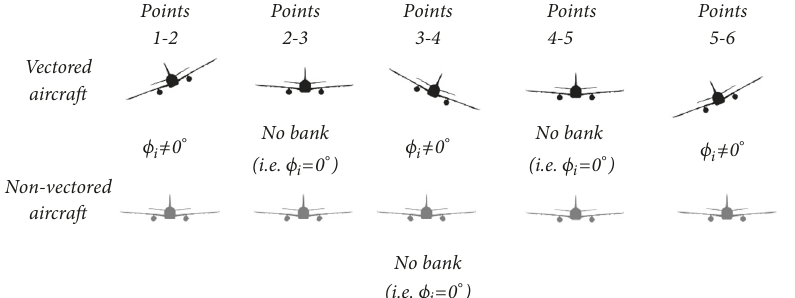
Figure 5: Bank angle variation of vectored and nonvectored aircraft along their flight